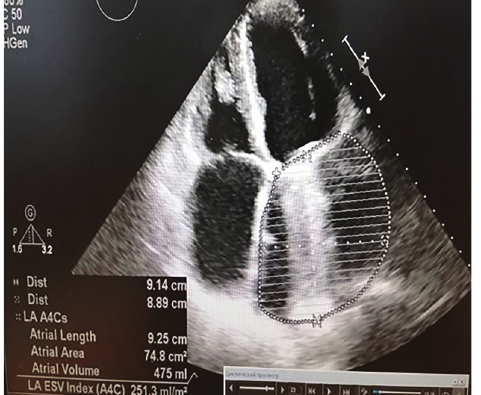
Figure 4 - Echo (24 hours after